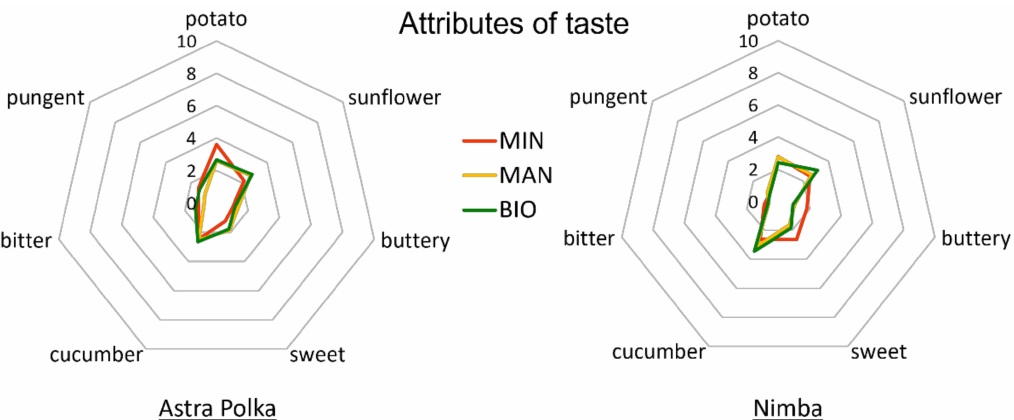
Figure 3. Intensity of taste attributes of courgette fruits of Astra Polka and Nimba cultivars grown in horticultural system with commercial organic fertilizer (BIO), manure (MAN), and mineral (MIN)